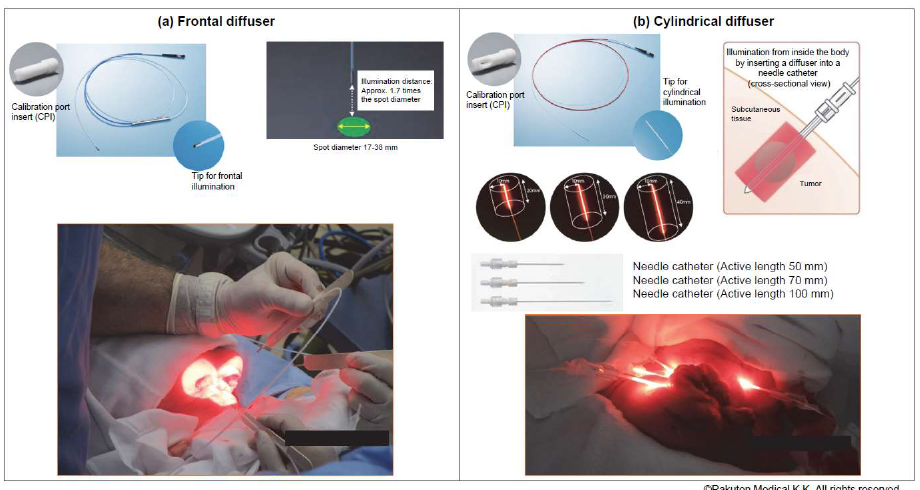
Figure 1. Illumination methods: A ( a ) frontal or ( b ) cylindrical diffuser. Cylindrical diffusers placed in needle catheters are used to treat subcutaneous or large tumors, whereas frontal diffusers are used to treat superficial tumors.